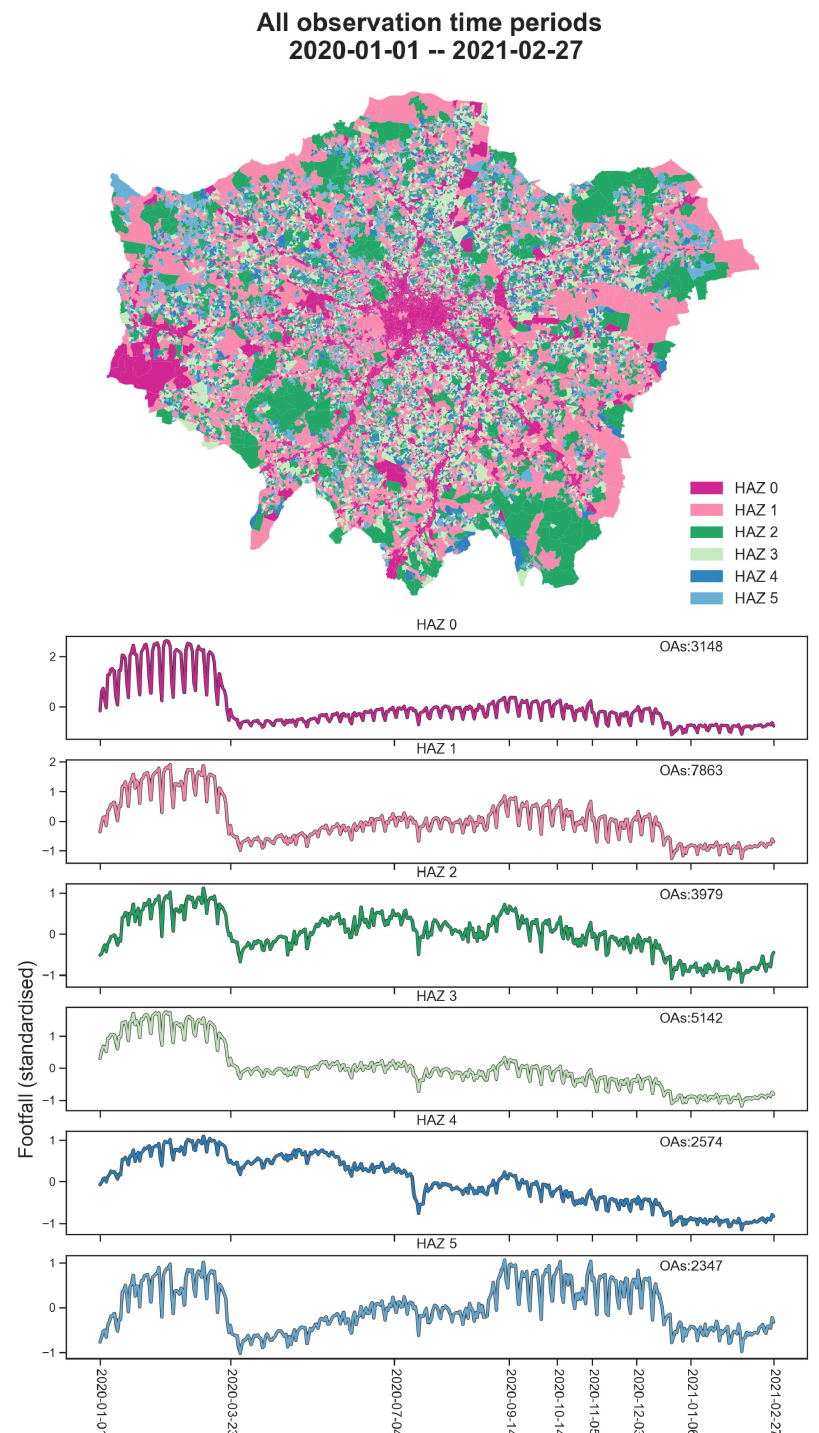
Fig 5. HAZs (top) and corresponding footfall patterns (bottom) of Greater London during all observation periods. The HAZs are ranked by the daily average footfall volumes from high level to low level. The temporal footfall variations for each HAZ are represented by the mean of all related OAs’ footfalls. (Geographical boundary data source: Office for National Statistics licensed under the Open Government Licence v.3.0. Contains OS data © Crown copyright and database right 2022. Contains National Statistics data © Crown copyright and database right